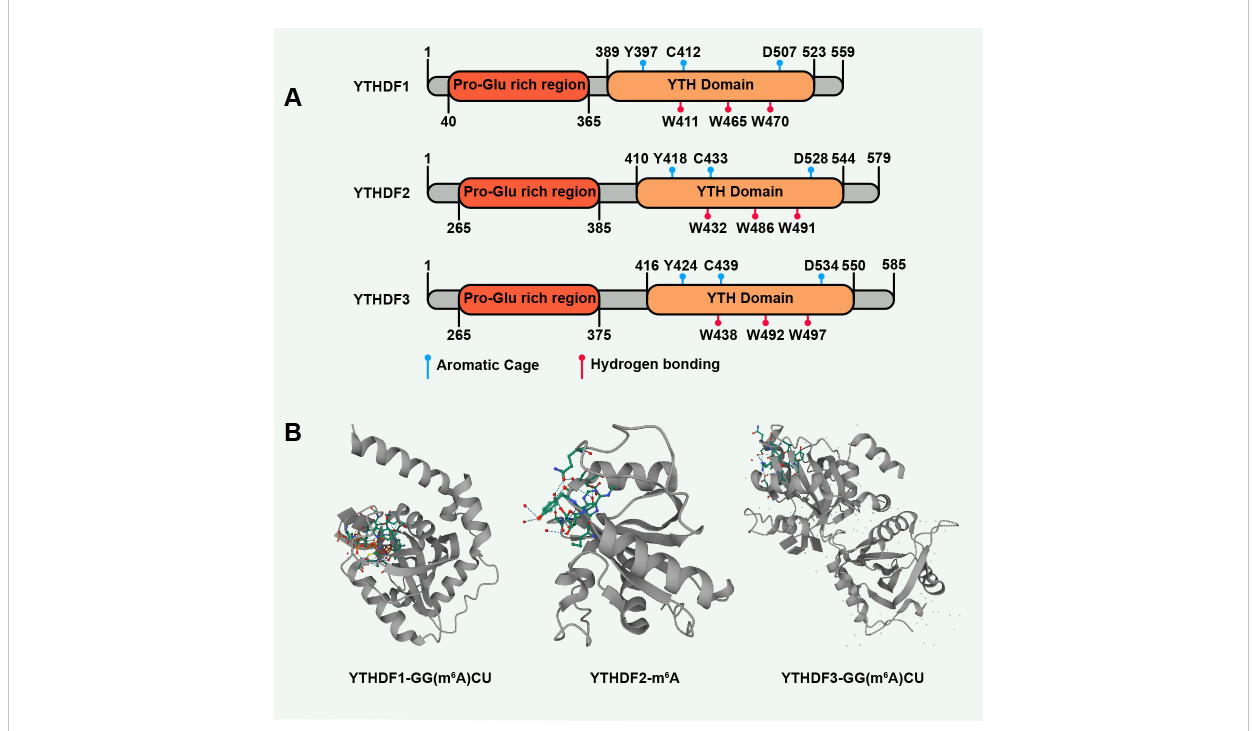
FIGURE 2 The structures of the YTHDF family, especially the YTH domain. (A) The YTH domain of YTHDFs: YTHDF1 (UniProt ID: Q9BYJ9), YTHDF2 (UniProt ID: Q9Y5A9), YTHDF3 (UniProt ID: Q7Z739). (B) Structures of YTHDFs in complex with m6A. YTHDF1 (PDB ID:4RCJ), YTHDF2 (PDB ID:4RDN), YTHDF3 (PDB ID:6ZOT). The secondary structures of proteins are shown in gray, and RNA molecules are shown in